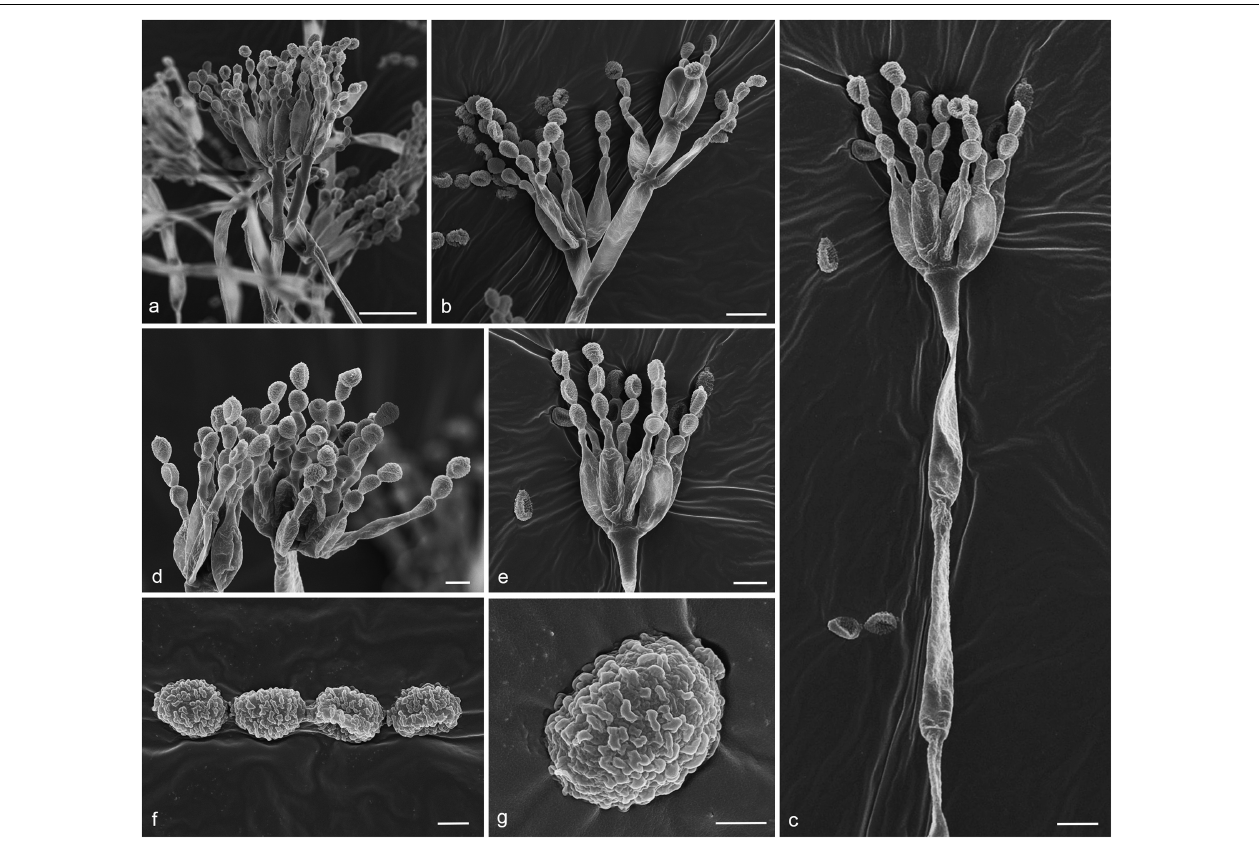
FIGURE 11 | Penicillium guaibinense (MFLU 20-0433). (a–c) Conidiophores and conidia. (d,e) Catenate conidia forming on phialides. (f) Conidia. (g) Close-up of conidia showing conidial wall. Scale bars: (a) = 10 µ m, (b,c) = 5 µ m, (d) = 2 µ m, (e) = 3 µ m, (f,g) = 1 µ m.